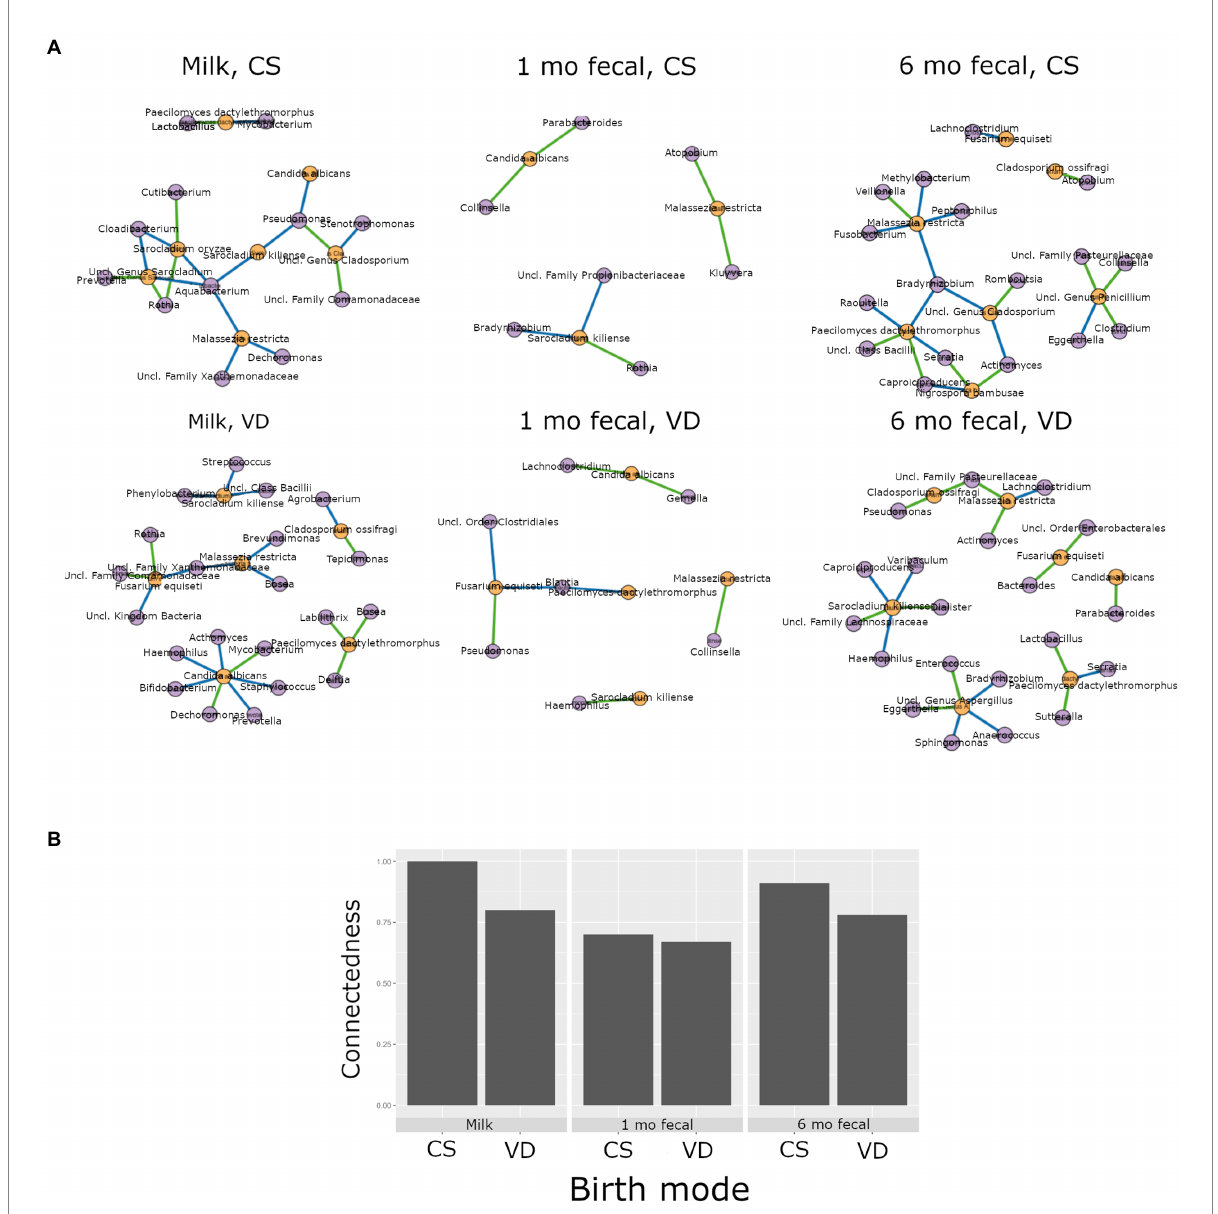
FIGURE 6 Interkingdom relationship comparisons by birth mode. Panels in A are interkingdom network maps of significant interactions between bacterial (purple) and fungal (orange) taxa and are organized by sample type. Blue line, negative correlation; green line, positive correlation. Plot in B is of interkingdom connectedness values (see Methods) by sample type. Sample n’s included in network analyses for Cesarean section delivery (CS, top row): breastmilk 12, 1-month feces 15, 6-month feces, 9 and for Vaginal delivery (VD, bottom row): breastmilk 62, 1-month feces 83, 6-month feces